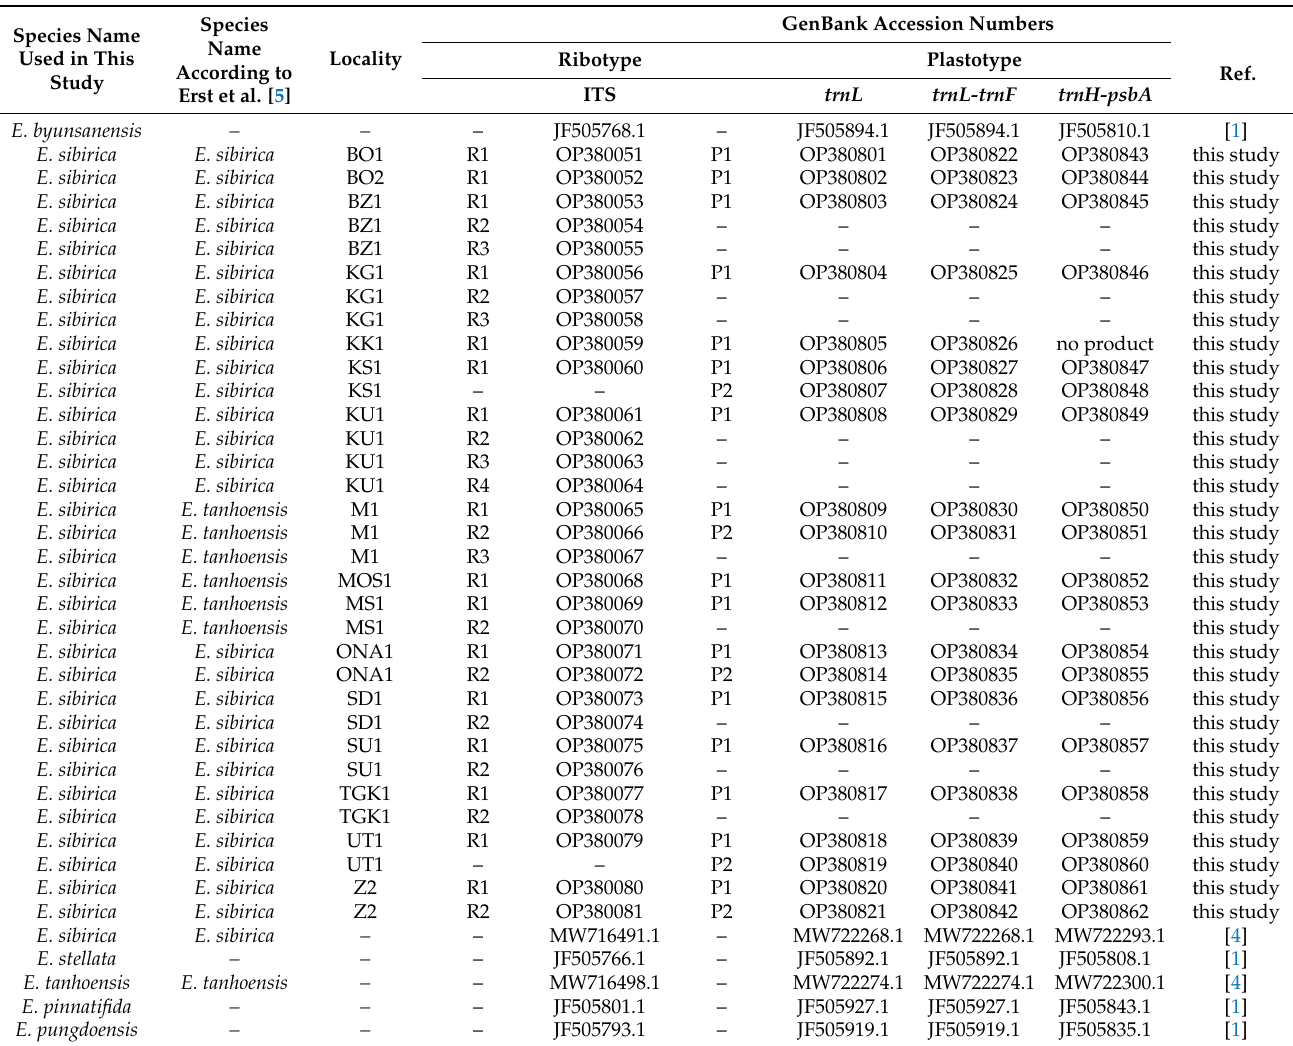
Table 2. The taxa and DNA sequences used for the phylogenetic